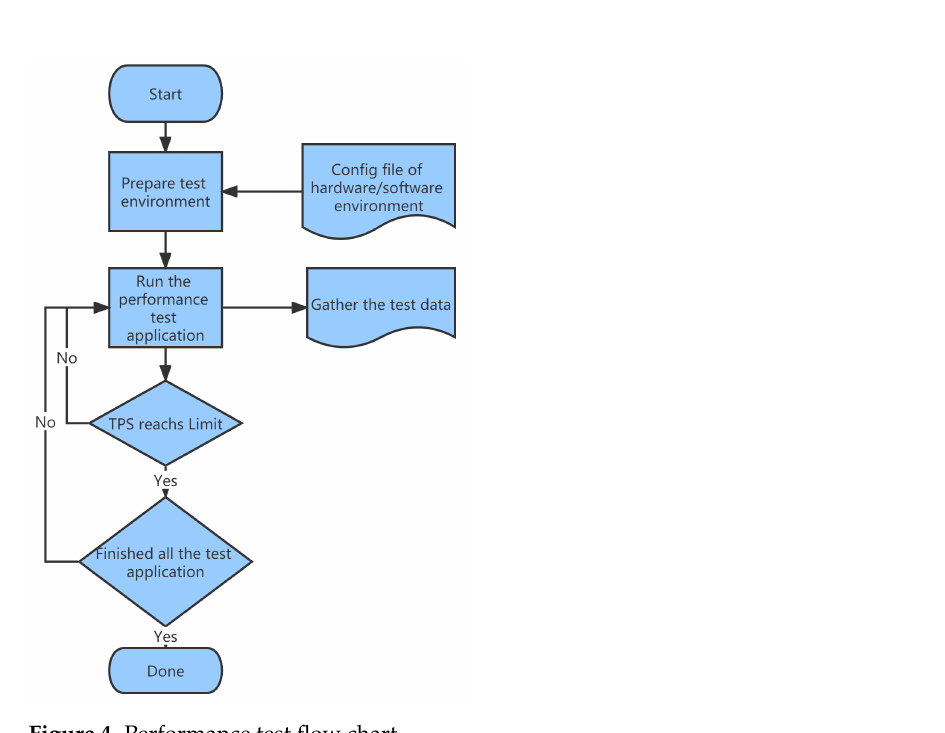
Figure 4. Performance test flow chart.